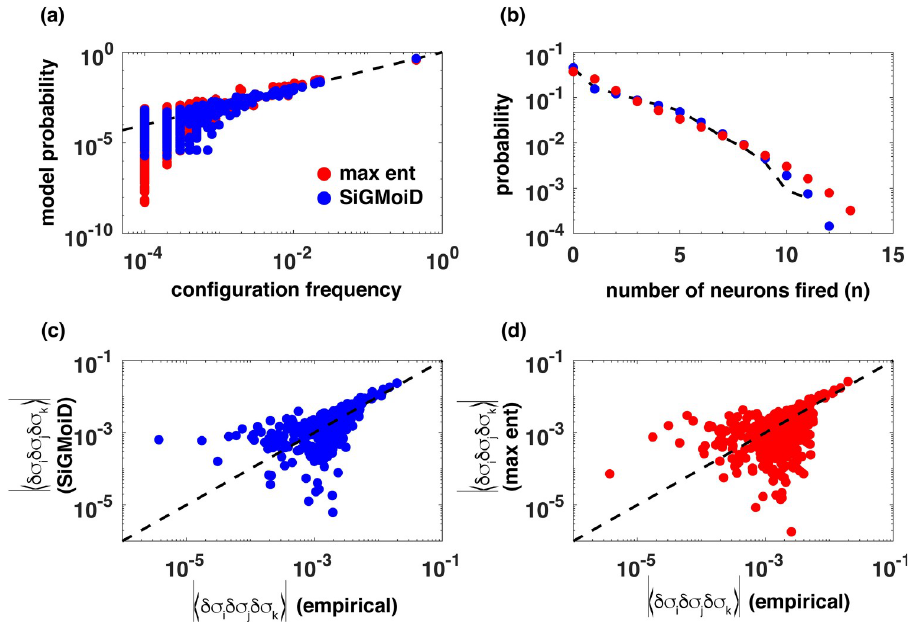
Fig 2. Comparison of SiGMoiD with max ent modeling. (A) the frequencies of individual configurations estimated from the samples (x-axis) and from the two models (y-axis), (red: max ent, blue: SiGMoiD). Only the frequencies of the 1442 configurations observed at least once in the samples are shown. (B) the probability that n neurons fire in any given configuration as estimated from samples (black), the max ent model (red), and SiGMoiD (blue), (C) and (D) comparison between the absolute values of three variable correlations h δ σ i estimated from data (x-axis) and ! i δ σ j δ σ k 15 those using the models (y-axis). There are ¼ 455 such 3